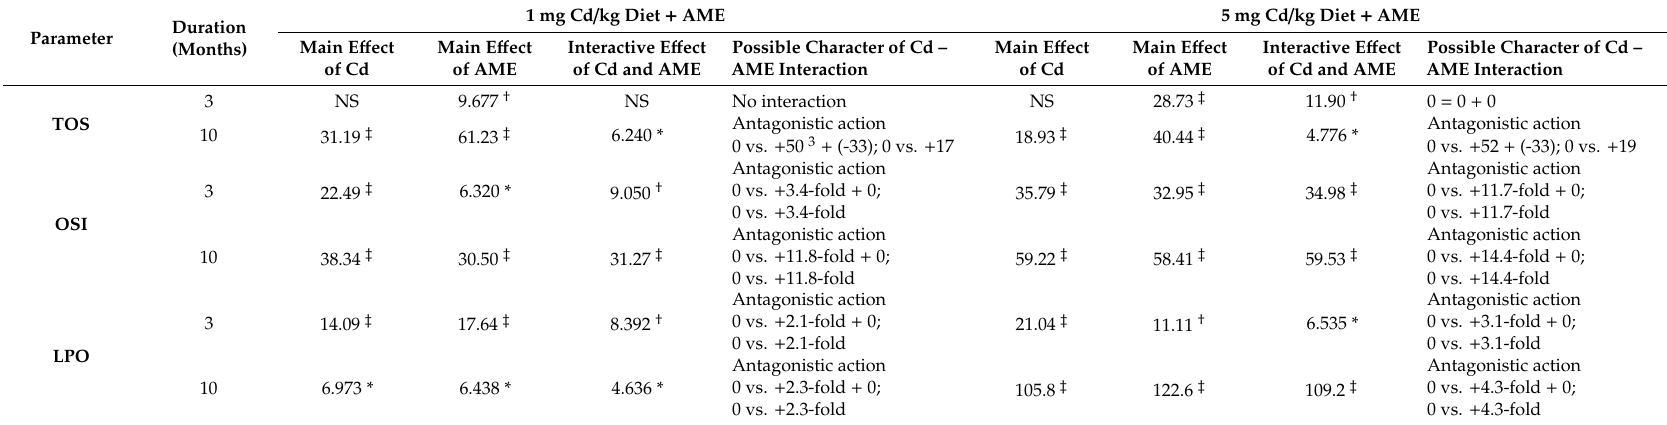
Table 3. Estimation of the main and interactive e ff ects of cadmium (Cd) and the extract from Aronia melanocarpa L. berries (AME) on the indices of the oxidative status of the submandibular gland of female rats 1,2 .